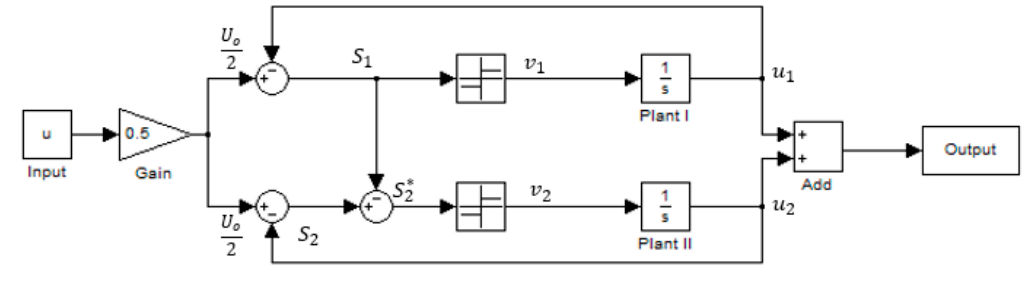
Figure 7. A two-phase master slide mode system.